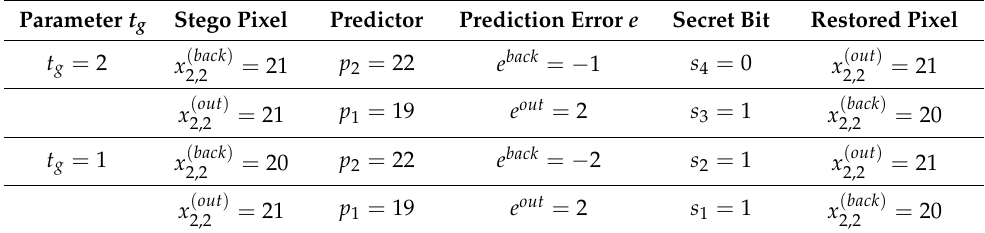
Table 4. Gray pixel value and changes in various values in the extraction